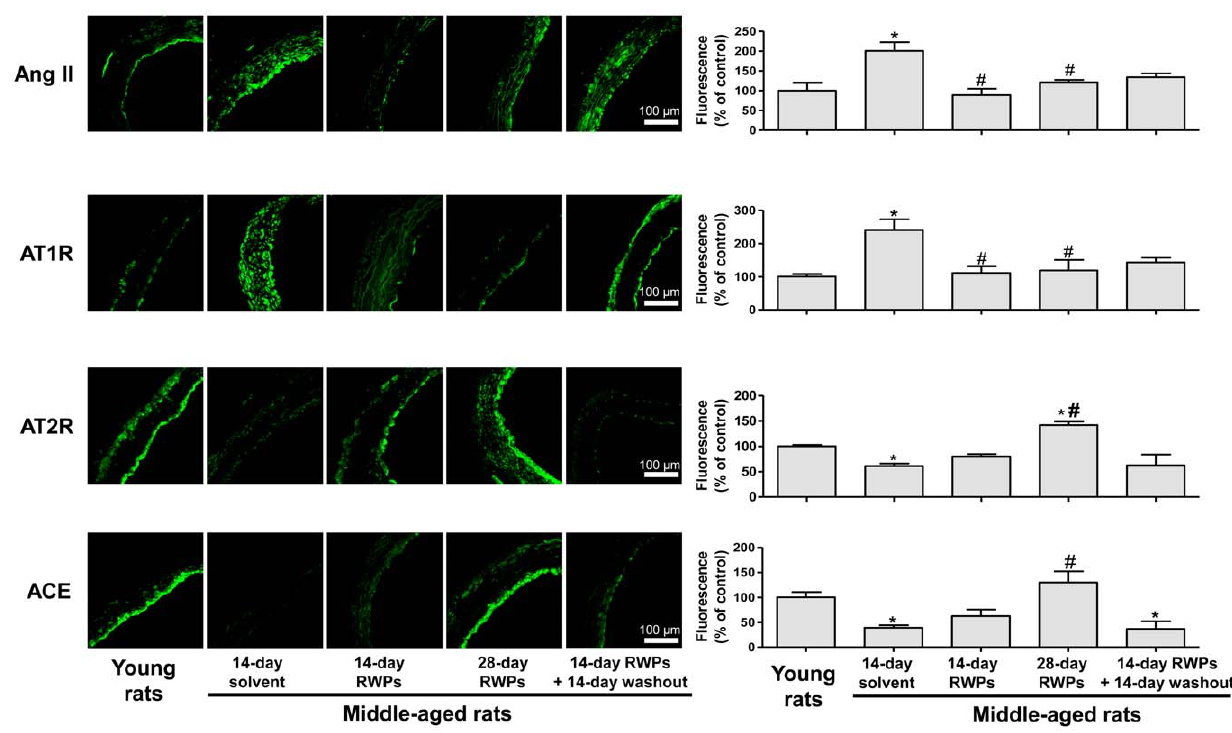
Figure 6. RWPs improve the aging-related over-expression of several components of angiotensin system in the mesenteric artery. The expression level of angiotensin II (Ang II), AT 1 receptor (AT1R), AT 2 receptors (AT2R) and angiotensin-converting enzyme (ACE) was determined by immunohistochemical staining. Left panels show representative immunofluorescence staining; right panels corresponding cumulative data. Results are shown as mean 6 SEM of 4 different rats. * P , 0.05 indicates a significant difference versus the young rat control group and # P , 0.05 versus the middle-aged rat control group. All micrographs were taken at the same magnification.